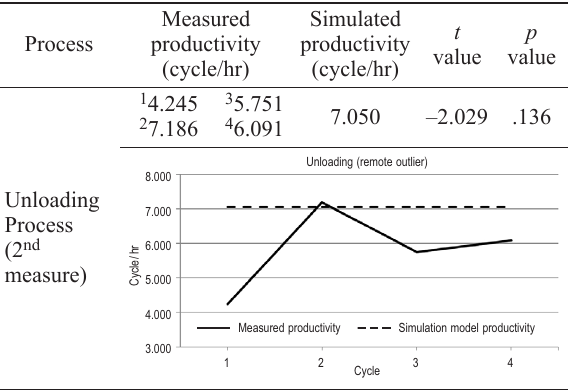
Table 7. T-test results between the measured and simulated productivity in the unloading process (2 nd measure) Measured Process productivity